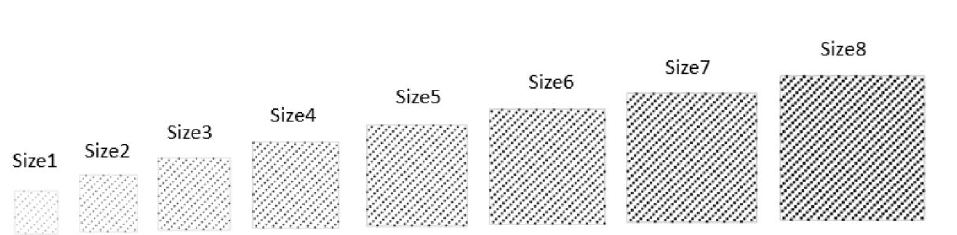
Figure 2. Relative Patch Surface Areas of woven electrode, smallest starts at 3.22 cm 2 and increases up to 32.26 cm 2 . All are 1/15 Sateen pattern type. Areas not to scale. Adapted from [21].